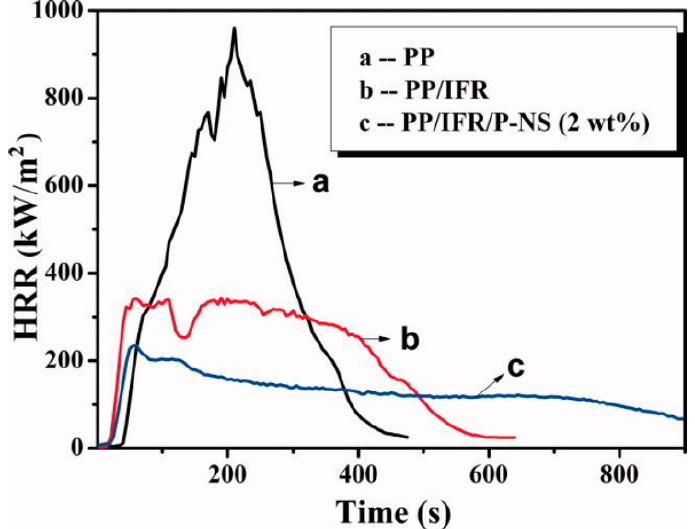
Figure 6. HRR of polypropylene (PP) ( a ), PP flame retarded with classical intumescent fire retardant formulation (IFR) formulation ( b ) and PP/IFR with 2% of P-NS as synergist. Reprinted with permission from ref [66].